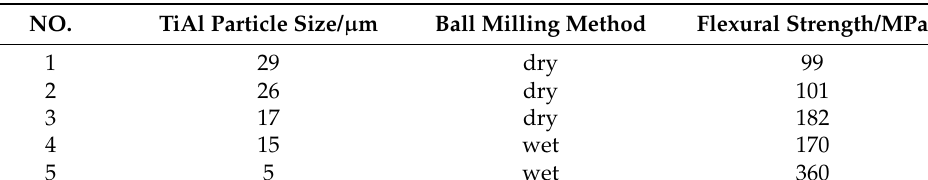
Table 3. Flexural strengths of cBN composites.